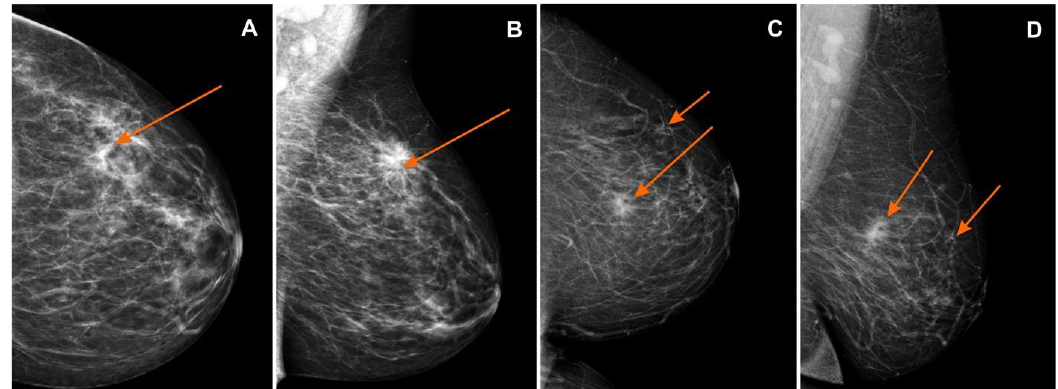
Figure 2. Mammography (MG): ( A ) craniocaudal (CC) and ( B ) mediolateral oblique (MLO) views—pathological mass in the left breast in the superior-outer quadrant (orange arrows), invasive lobular carcinoma GII, BI-RADS 6; ( C ) craniocaudal (CC) and ( D ) mediolateral oblique (MLO) views—pathological mass in the left breast in the superior-inner quadrant (orange arrows), infiltrating duct carcinoma, BI-RADS 6. BI-RADS: Breast Imaging-Reporting and Data System.